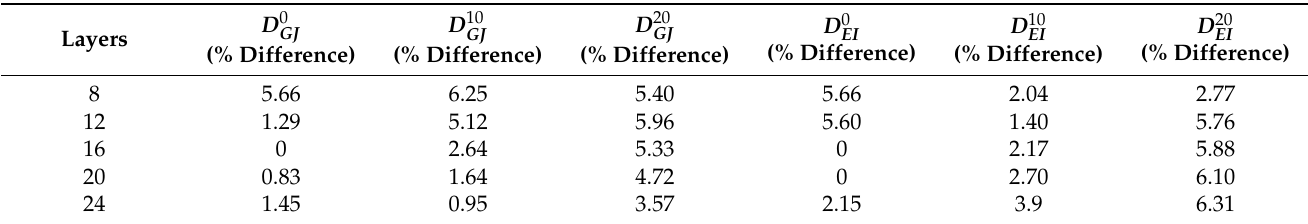
Table 4. Difference between the FEA and analytical method.